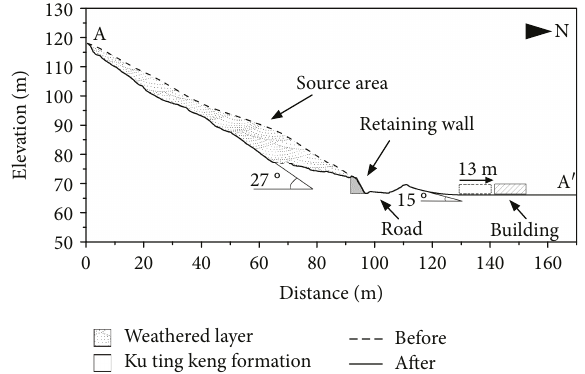
Figure 3: Schematic of the terrain and geomaterials of the study area (after Chen